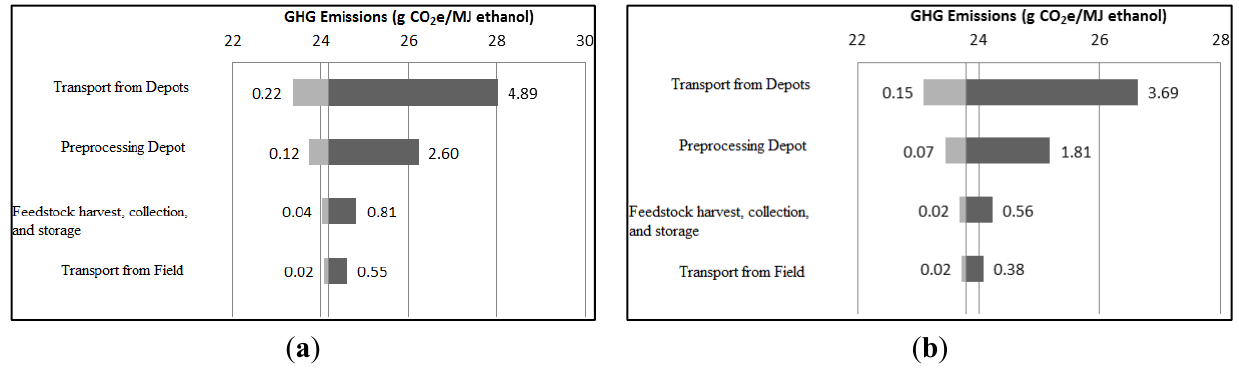
Figure 6. Sensitivity analysis of processes: feedstock harvest, collection, and storage; transport from field; preprocessing depot; and transport from depot to biorefinery on life cycle GHG emissions for: ( a ) Scenario 1; and ( b ) Scenario 2. The tornado diagram shows that GHG emissions (measured as global warming potential (GWP)) are most sensitive to the transport from depot (top process) and least sensitive to transport from field (bottom process). An increase in GHG emissions sensitivity is shown in 50% gray; and a decrease in GHG emissions sensitivity is shown in 30%